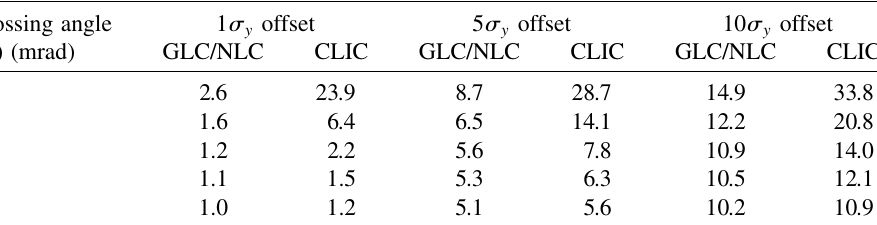
) of the last of the train for various y